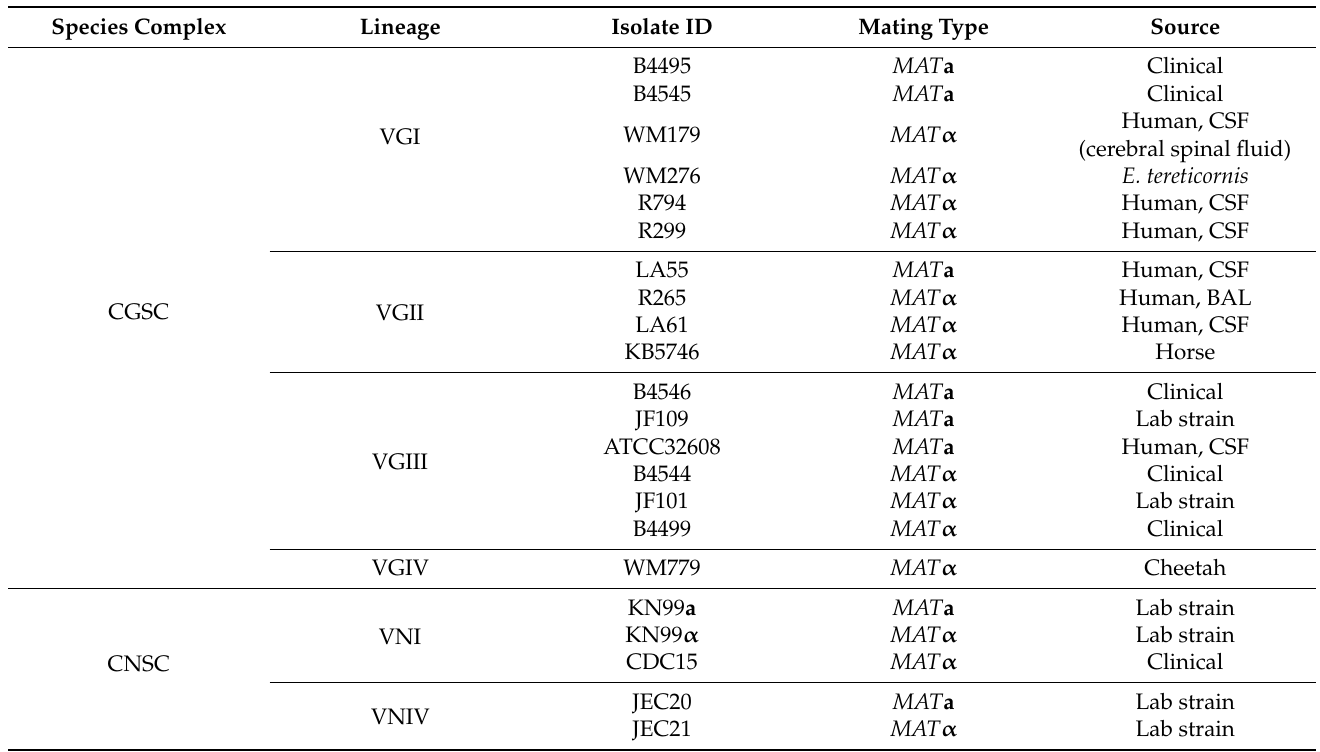
Table 1. Strains of the C. neoformans species complex (CNSC) and C. gatii species complex (CGSC) were used as parents in this study. Species